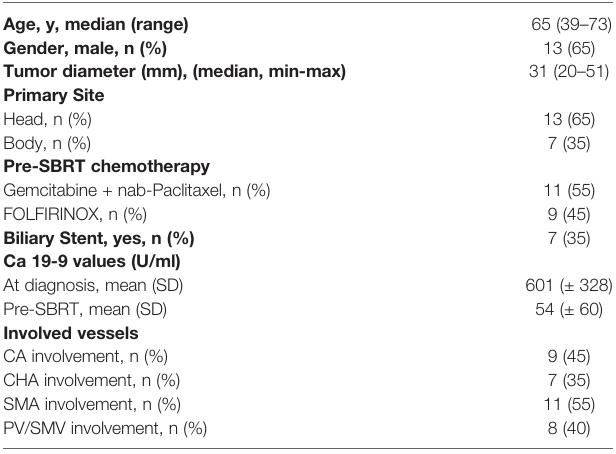
TABLE 2 | Baseline characteristics of locally advanced pancreatic cancer patients (n = 20). Age, y, median